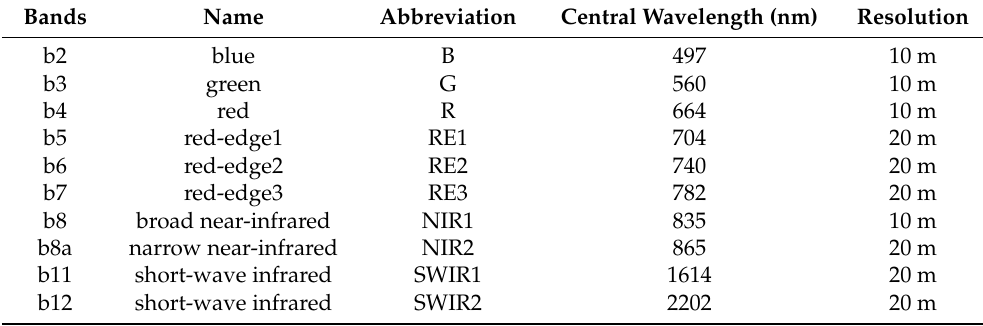
Table 1. Spectral and spatial features of imagery band data acquired by Sentinel sensors.